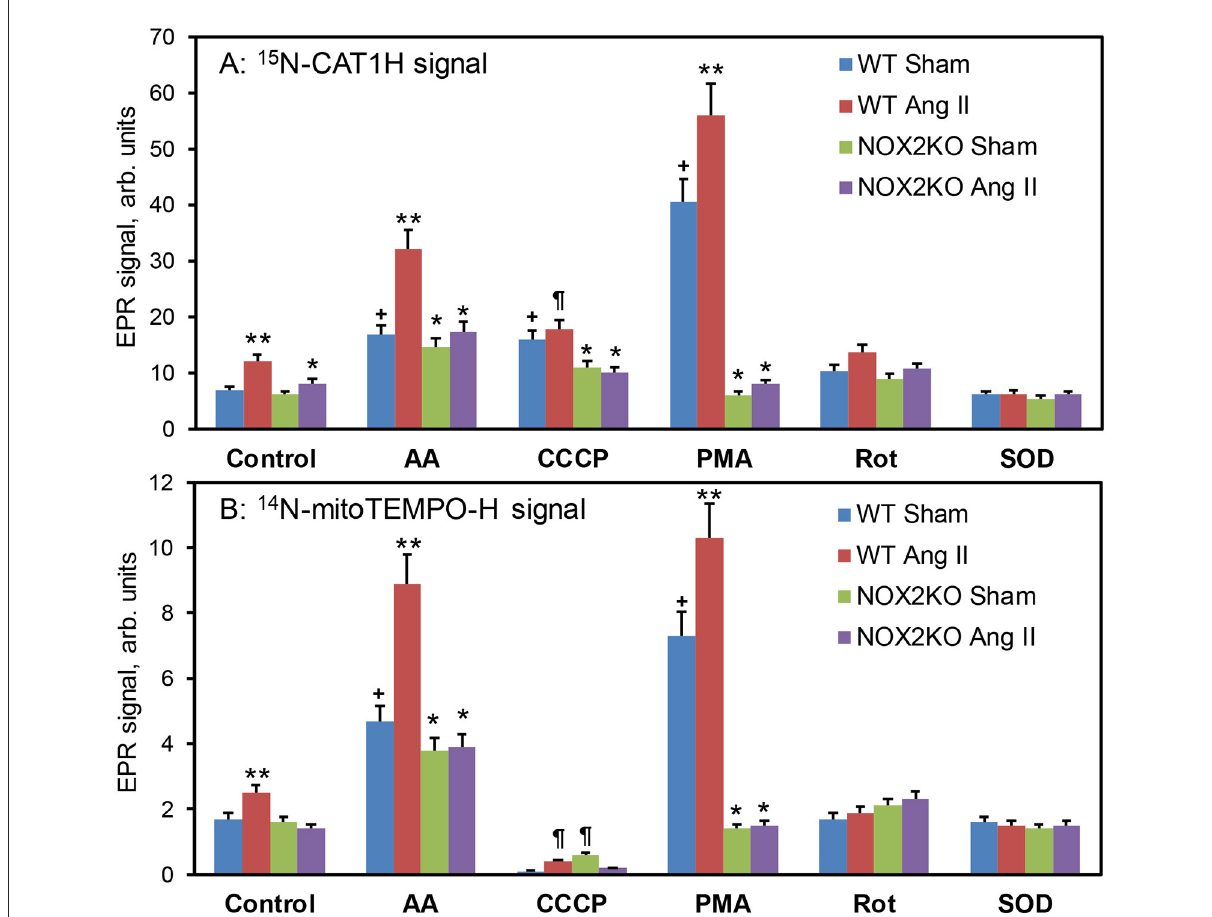
FIGURE4 EPR analysis of extracellular and mitochondrial O 2 • by 15 N-CAT1H (A) and 14 N-mitoTEMPO-H (B) spin probes in splenocytes. Wild-type C57Bl/6J and Nox2KO mice were infused with saline (Sham) or angiotensin II (Ang II, 0.3 mg/kg/day) for 14 days prior to EPR studies. Isolated splenocytes were placed in Krebs-Hepes buffer (10 7 /ml) and treated acutely with antimycin A, CCCP, PMA, rotenone or Cu,Zn-SOD and incubated with 15 N-CAT1H (500 µ M) and 14 N-mitoTEMPO-H (25 µ M) for 30min at 37 ◦ C prior to EPR analysis. Extracellular O 2 • production was measured by accumulation of 15 N-CAT1H nitroxide following low field component of EPR spectra. Mitochondrial O 2 • production was measured by accumulation of 14 N-mitoTEMPO nitroxide following central field component of EPR spectra. Results are mean ± SEM ( n = 6). * P < 0.01 vs. WT + Ang II, ** P < 0.05 vs WT Sham, ¶ P < 0.01 vs. Control, + P < 0.01 vs. WT